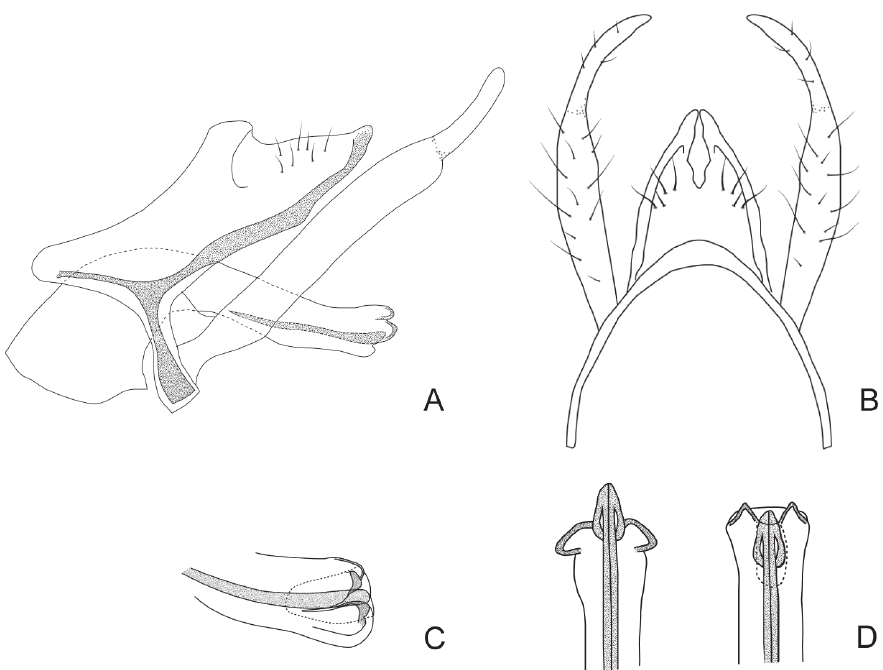
Figure 6. Male genitalia of Smicridea ( Rhyacophylax ) atrobasis A segments IX, X, inferior appendages and phallus, lateral view B segments IX, X and inferior appendages, dorsal view C tip of the phallus, lateral view D tip of the phallus, dorsal view (left evaginated, right